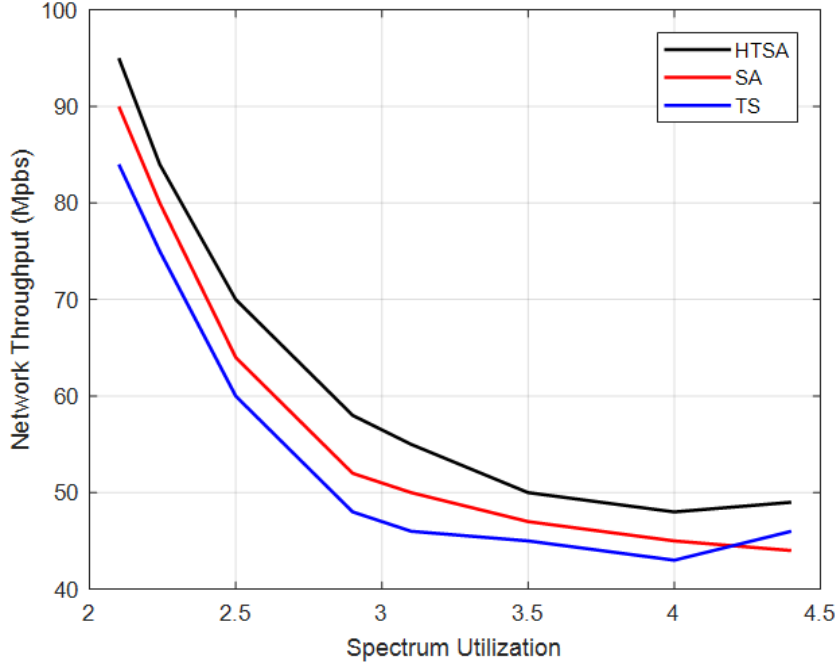
Figure 7. Convergence analyses of heuristic algorithms.